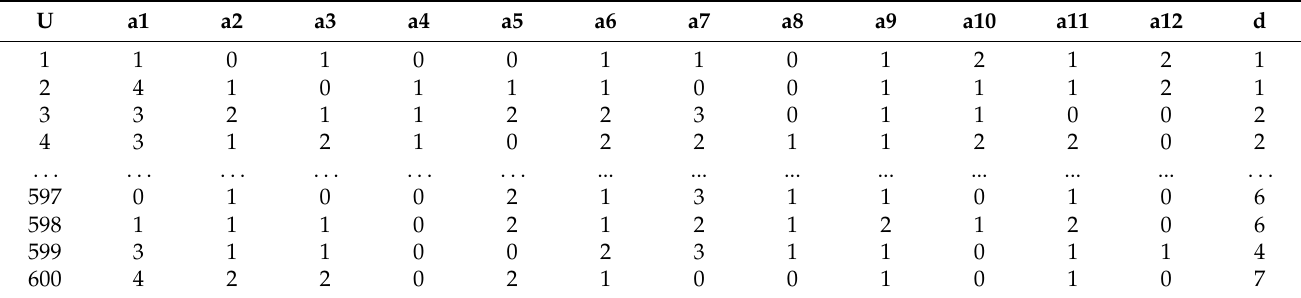
Table 5. Decision table after discretization.